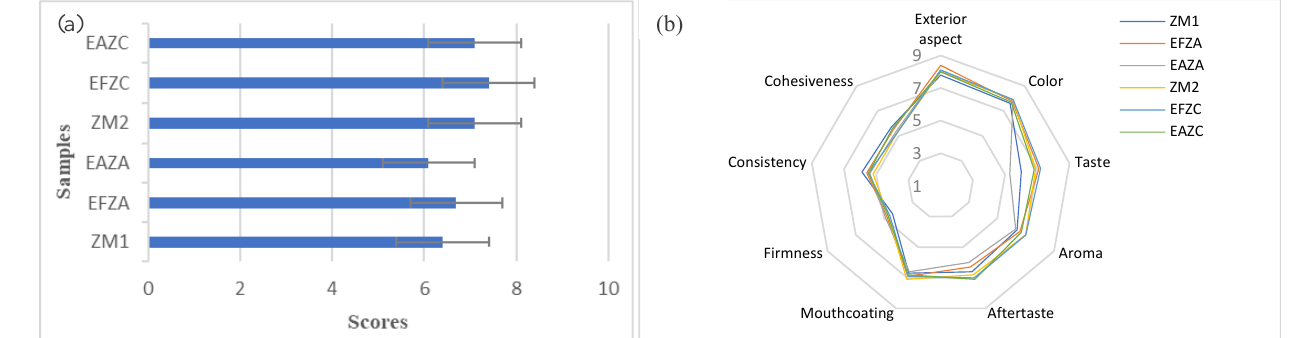
Figure 7. Overall acceptance ( a ) and comparative diagram of the sensory attributes specific to purees ( b ). ZM 1 and ZM 2 are zucchini purees treated by steam convection and hot air convection, respectively; EFZA and EAZA are zucchini purees mixed with fennel or anise aqueous extract, processed by steam convection; EFZC and EAZC are zucchini purees mixed with fennel or anise aqueous extract, treated by hot air convection.